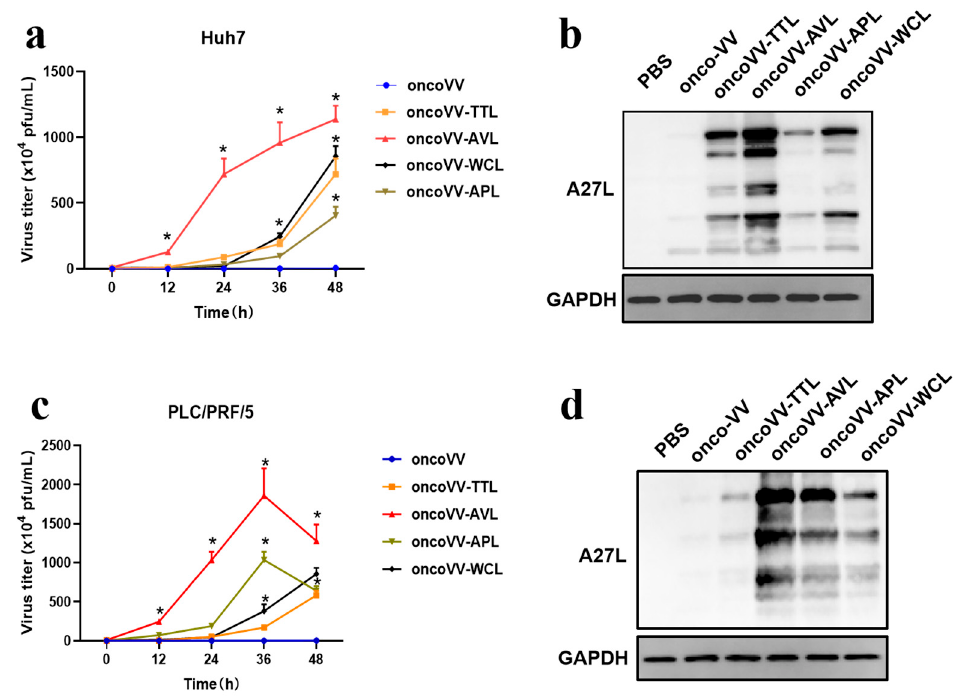
Figure 3. Lectins enhanced oncoVV replication in Huh7 ( a , b ) and PLC/PRF/5 ( c , d ) cells. Viral replication was determined by TCID 50 assay. HEK293A cells (8 × 10 4 cells/well) were cultured for 12 h and then infected with vaccinia viruses at 5 MOI. The viruses were collected at 0, 12, 24, 36, and 48 h, and then diluted successively (10 − 1 ~10 − 9 ). Diluted suspensions were then added to HEK 293A cells and viral plaque holes were counted. The formula T = 7 × 10 (d + 0.5) PFU/mL (d = sum of positive proportion) was used to calculate the viral titer [29,30]. The levels of A27L were detected by WB. PBS and oncoVV served as controls, and GAPDH was a loading control. (* p < 0.05).